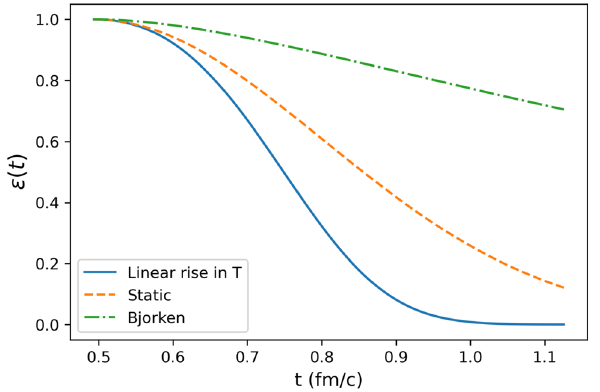
Fig. 3 E ( t ) as a function of time with the additional simplification f ( z ) = 1 (solid line) and with the complete K in Eq. (4) (dashed line), for the case of linear rise in